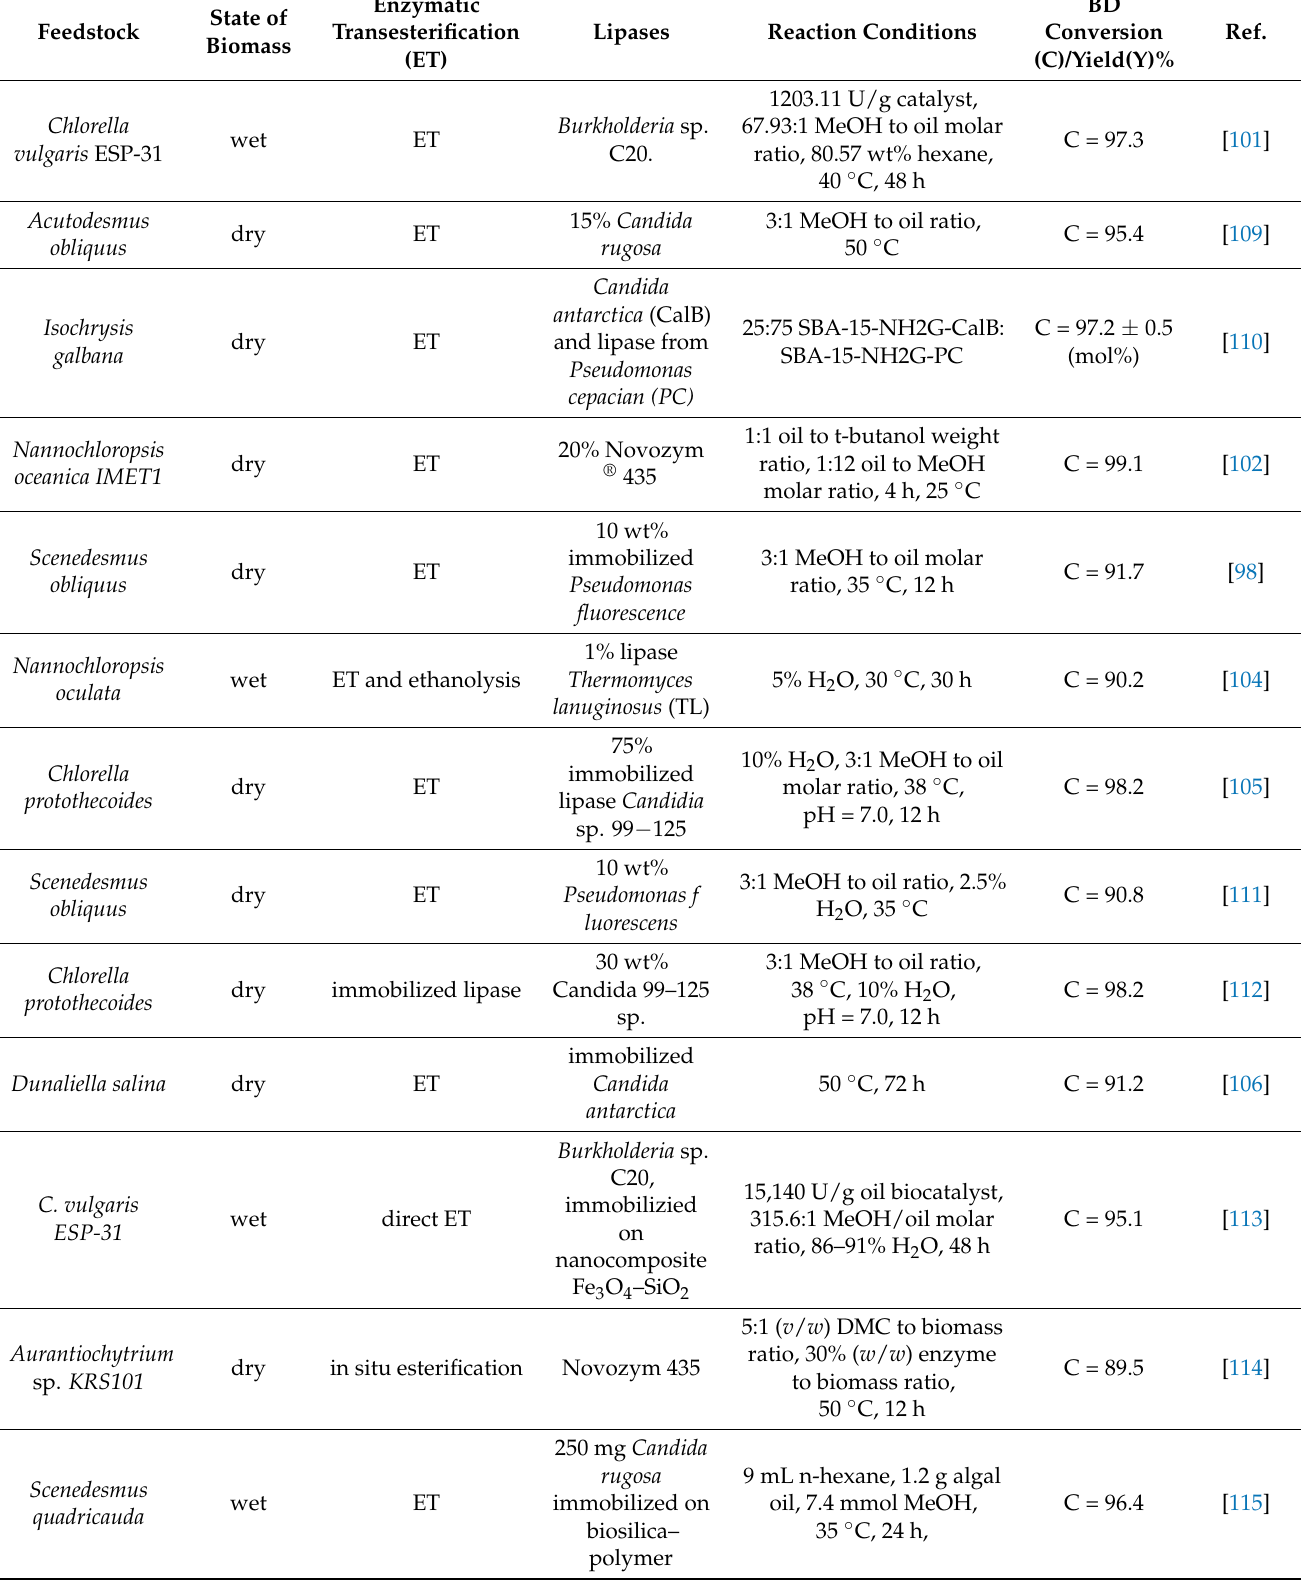
Table 6. Enzymatic BD production from different